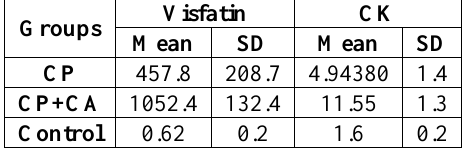
Table 4: The mean values of salivary visfatin and CK among the groups of the